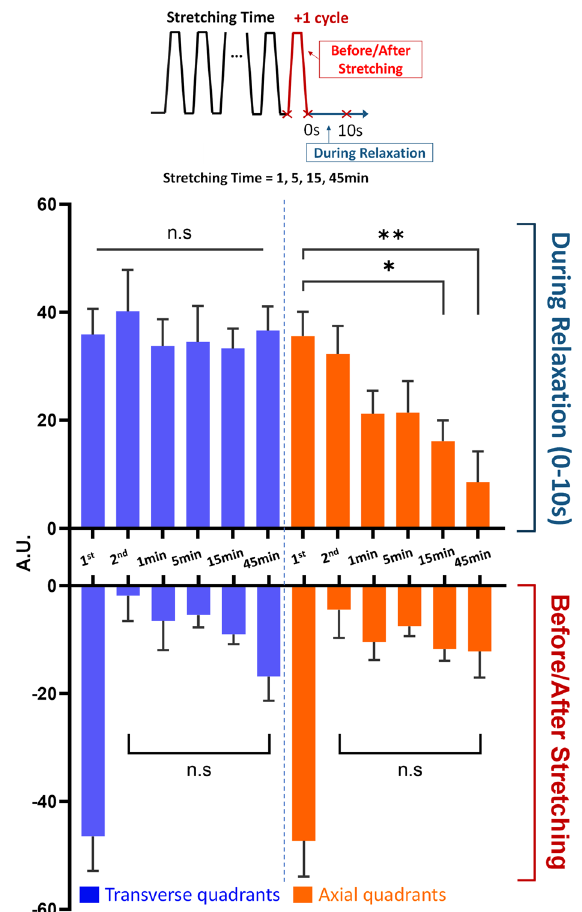
Figure 4. Differential axial and transverse responses following multiple cycles of stretching. Changes in peripheral areas are measured at the 1 st cycle, 2 nd cycle, and after various periods of cyclic stretching at 0.5 Hz as shown in the diagram, where the timing of image acquisition relative to the stretching cycles is indicated by red crosses. Local retractions or protrusions of different quadrants are then integrated and normalized against the total spreading area to reveal net extension (positive values) or retraction (negative values). Note that while the relaxation phase lasts for 1 s for cyclic stretching at 0.5 Hz, given the slow, persistent nature of extension, net extension was measured over a period of 10 s to improve the accuracy, after halting the cyclic stretching. Therefore, the actual extension during the relaxation phase is approximately 10% of the values shown in the upper graph. Net retraction takes place immediately after stretching (lower graph), while net extension takes place during subsequent 10 s of relaxation (upper graph). Moreover, net extension of axial quadrants decreases progressively with increasing cycles of stretching (top orange), while net extension of transverse quadrants remains constant (top blue). Retraction occurs similarly in all the quadrants, showing a strong response following a single cycle of stretching and a precipitous decrease with additional cycles of stretching (bottom graphs) (* p < 0.05; ** p < 0.01; n = 16–20, mean ±